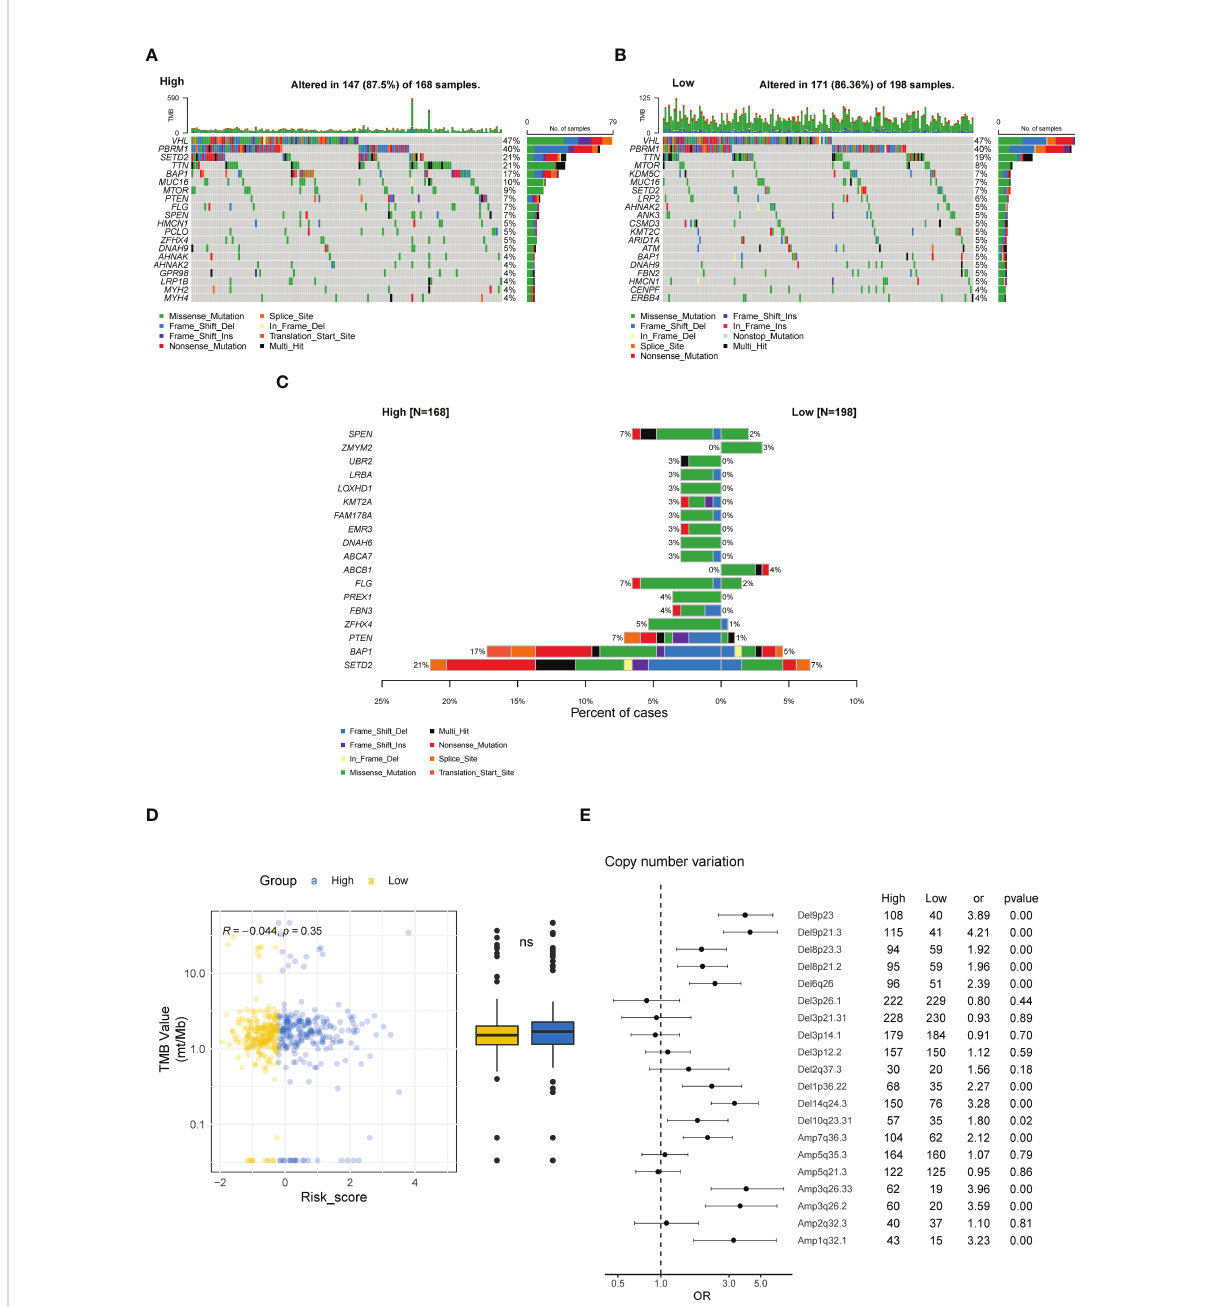
FIGURE 8 Genomic characteristics related to CTR score. Oncoplots of the top 20 altered genes in the high (A) and low CTR groups (B) . (C) Genes with signi fi cantly differed prevalence between the high and low CTR groups. (D) Difference in the tumor mutational burden (TMB) level between the high and low CTR groups. (E) Difference in the prevalence of copy number variations (CNV) between the high and low CTR groups. Odds ratio (OR) > 1.0 indicated a higher prevalence in the high CTR group; conversely, OR< 1.0 indicated that the event was more prevalent in the low CTR group. TMB, tumor mutation burden; CNV, copy number variant; Del, deletion; Amp, ampli fi cation; ns, not signi fi